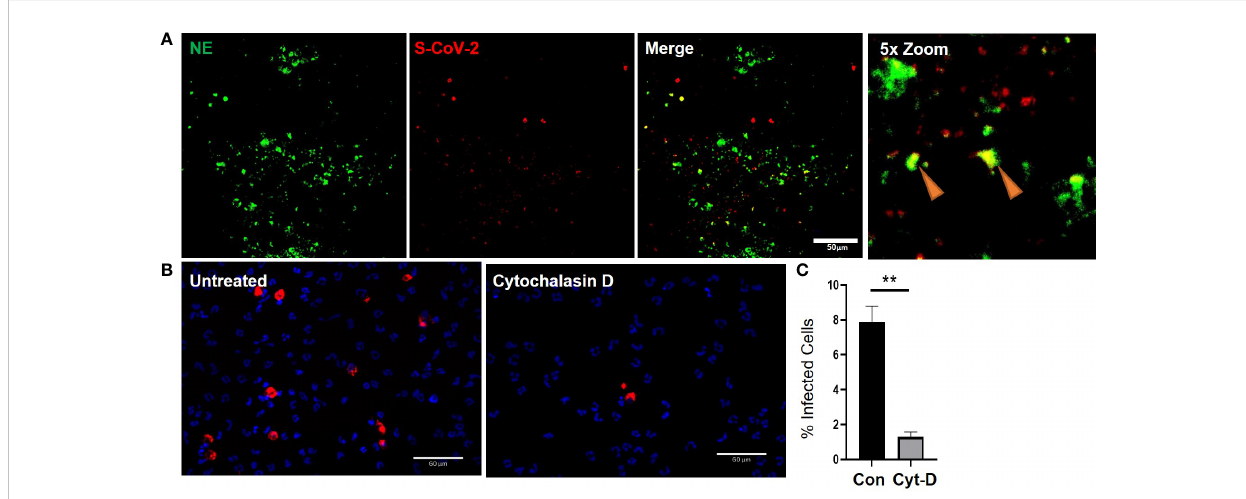
FIGURE 5 Cytochalasin D inhibits internalization of SARS-CoV-2 in neutrophils. a) Representative IF images of ALI cultures probed for neutrophil elastase (NE) (Green) infected with SARS-CoV-2 (red) detected by RNAScope. b) Quanti fi cation or SARS-CoV-2 positive neutrophils relative to total number of neutrophils determined by DAPI (blue). Data expressed as mean ± SEM. **p<0.01 unpaired 2-tailed Student ’ s T-test. N=3 independent neutrophil donors, n=3 experimental